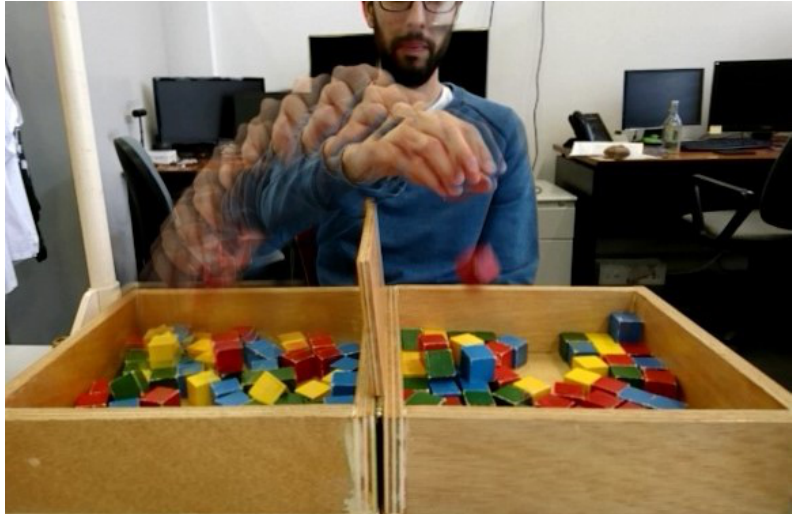
Figure 1. Equipment and use mode of the